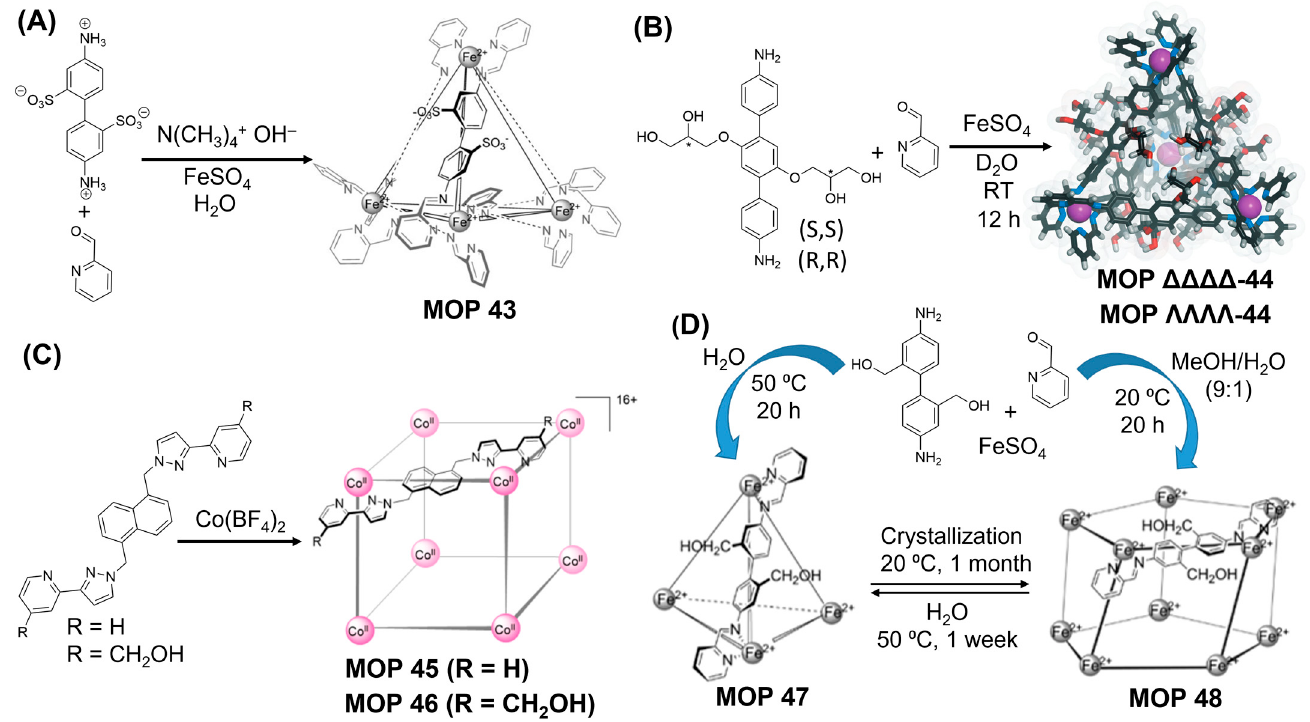
Figure 19. ( A ) Preparation of tetrahedron MOP 43 by aqueous subcomponent self-assembly. ( B ) Enantioselective formation of tetrahedron MOP ΔΔΔΔ -44 and MOP ΛΛΛΛ -44 from enantiopure (S,S/R,R) diamine, 2-formylpyridine and Fe II SO 4 by subcomponent self-assembly. ( C ) Preparation of cubic MOP 45 and MOP 46 from the corresponding ligand and Co(BF 4 ) 2 salt via self-assembly. ( D ) Subcomponent self-assembly of tetrahedron MOP 47 and prism MOP 48, and their interconversion. Reprinted by permission from Refs. [62,169–171]. Copyright 2008 and 2013 from Wiley-VCH. Copyright 2013 from Royal Society of Chemistry.